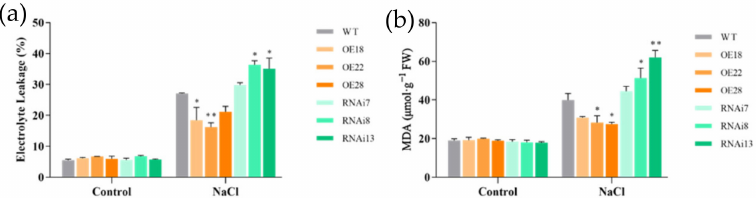
Figure 6. Effects of NaCl treatment on relative electrolyte leakage and malondialdehyde levels of wild-type (WT), overexpression (OE18, OE22, and OE28), and RNAi lines (RNAi7, RNAi8, and RNAi13). ( a ) Electrolyte leakage and ( b ) malondialdehyde (MDA) levels were determined after 6 d of NaCl treatment. The experiment was repeated three times, and each treatment included four replications. Data are means ± SE ( n = 3). An asterisk indicates a significant difference (LSD test, * p < 0.05 and ** p < 0.01) between wild-type, overexpression, and RNAi